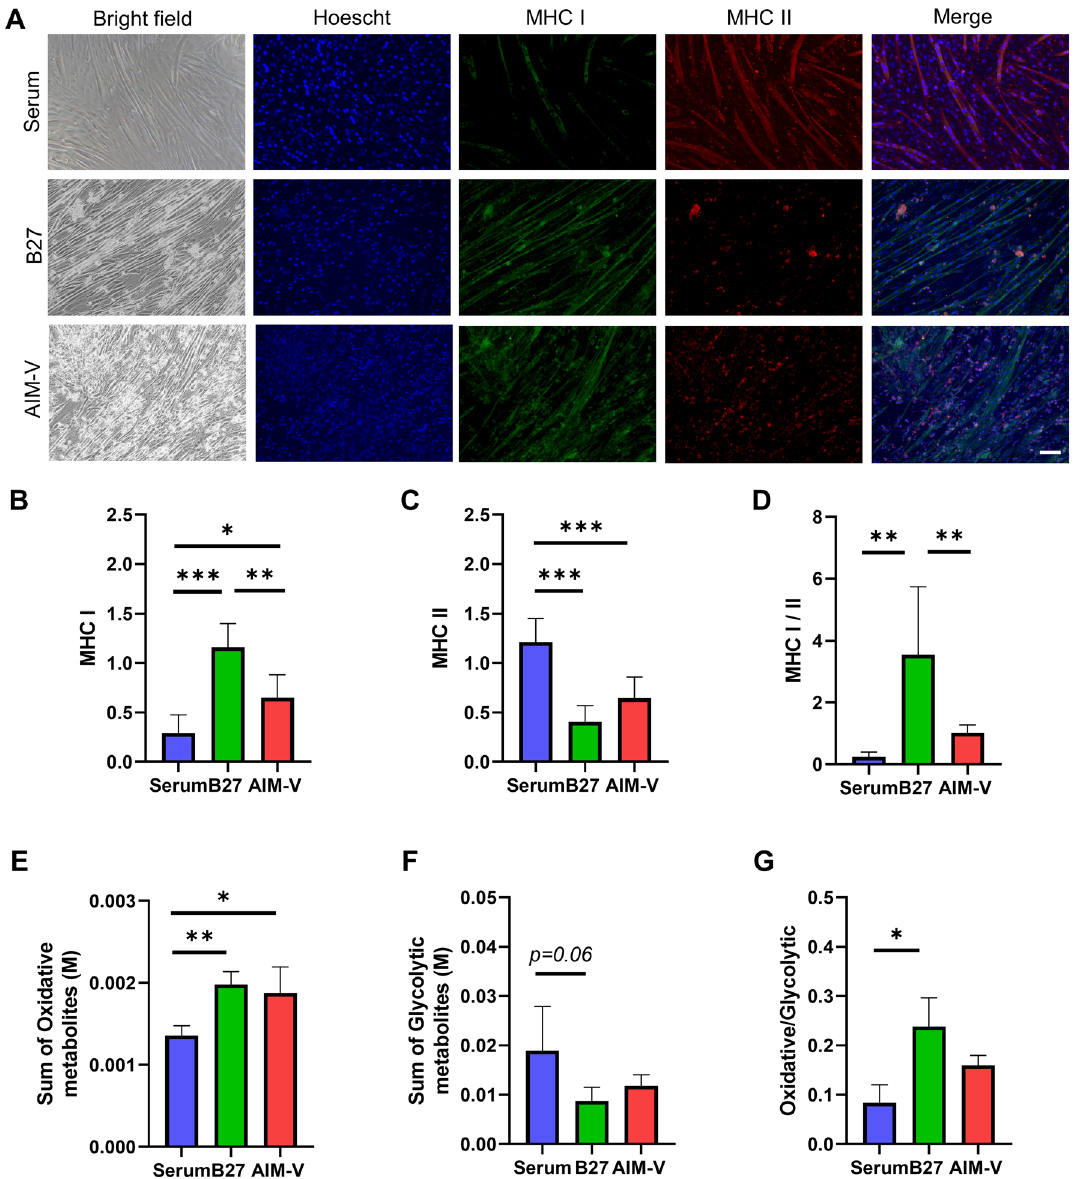
Figure 8. ( A ) Representative images of phase-contrast and immunostaining of MHC I and II in C2C12 cells at day 7 in Serum, B27, and AIM-V cultures. Images show immunostaining for MHC I (green), MHC II (red) and Hoechst counterstained nuclei (blue). Merged panels show composite images. Scale bar indicates 100 µm. Quantification of MHC I and II images from A was shown following figures. The positively MHC I and II— stained area was normalized to nuclei area. ( B ) Quantification results of MHC I (slow type)—positive stained myotubes. ( C ) Quantification of MHC II (fast type)-positive stained myotubes. ( D ) The ratio of quantified MHC I to MHC II, indicating slow type of muscle is more dominant. The experiments were performed three times and representative results are shown. ( E ) The sum of the glycolytic metabolism-related metabolites (G6P, F6P, F1, 6BP, 2/3-PG, PEP, Pyr, and Lac) and ( F ) Oxidative metabolism-related metabolites (Cit, Icit, aKG, Suc, Fum, IA, and Mal). ( G ) The ratio of sum of oxidative to glycolytic-related metabolites. Data presented as average ± standard deviation (SD). (n) = 4. *p < 0.05, **p < 0.01, ***p <